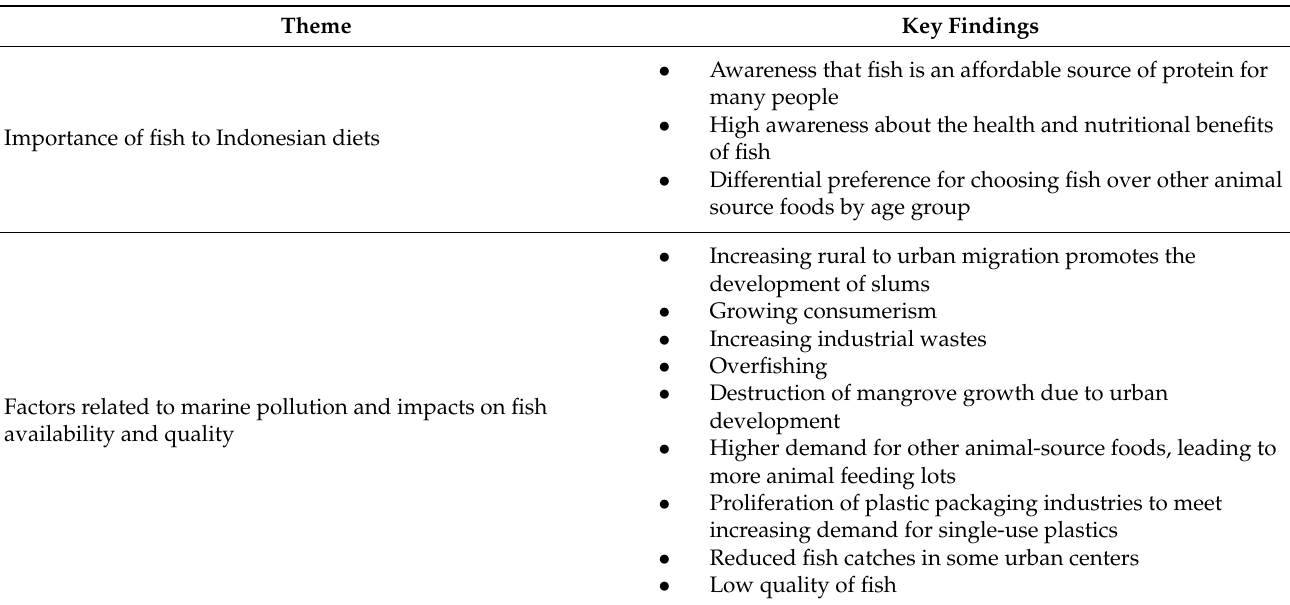
Table 3. Summary of Informants’ Perspective on Marine Pollution and Fish